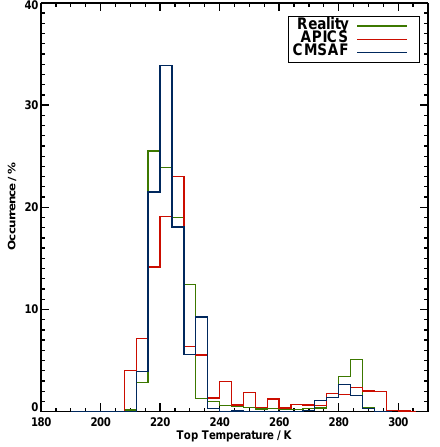
Fig. 8. Histograms of real, APICS and CMSAF cloud top tempera- tures.